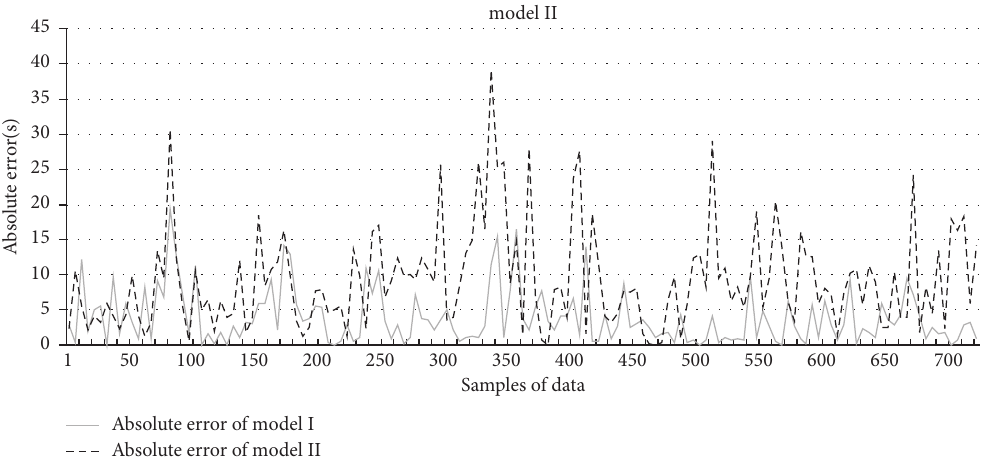
Figure 5: Comparison of the absolute errors between model I and model II. Table 7: Comparison of MAE between model I and model II (unit: second).